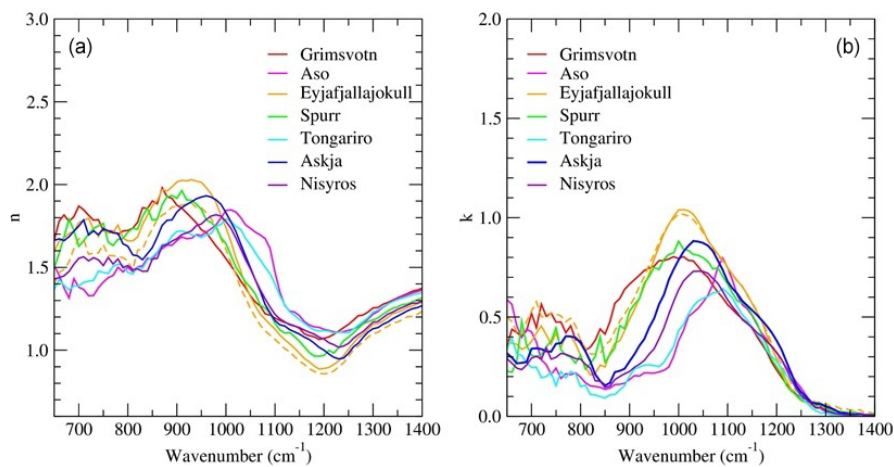
Figure 3. Real n (a) and imaginary k (b) parts of the RE2018 complex RI models (RI = n + i · k ). For Eyjafjallajökull ash samples, the solid and dashed yellow lines indicate Eyjafjallajökull-a and -b, respectively. See Table 1 for the abbreviations, NBO/T values, and SiO 2 wt% of each RI model.